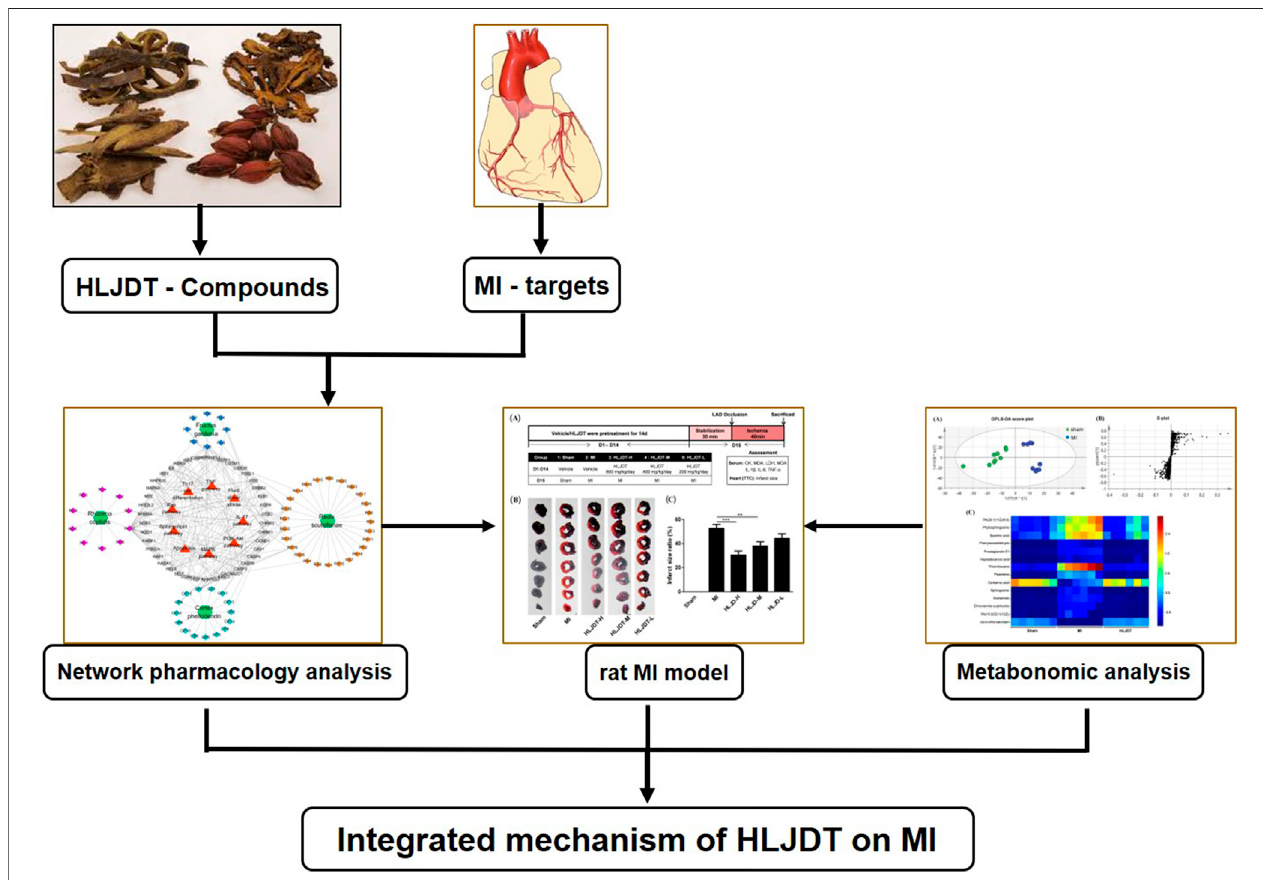
FIGURE 1 | Integrated fl owchart for elucidating the mechanism of HLJDT in the treatment of MI. Firstly, a global view of the potential compound – target – pathway networkbasedonnetworkpharmacologywasconstructedtoprovideapreliminarymechanismspredictiontheofHLJDTforelucidatingitsmolecularmechanismsinMI. Subsequently, in vivo ef fi cacy of HLJDT was validated in a rat model. Meanwhile, the corresponding metabonomic pro fi les were used to explore differentially induced metabolicmarkersthusproviding themetabolicmechanismofHLJDTintreatingMI. Theseresultswilldemonstratethemyocardial protectioneffectand illustrating the mechanism of HLJDT for the treatment of